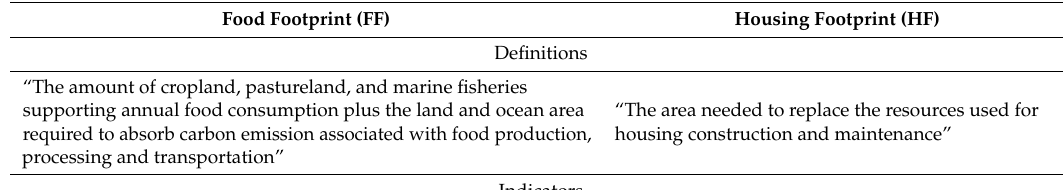
Table 2. Definitions and indicators used in the Redefining Progress programme for calculating Footprints (table adapted from Fern á ndez et al. [14]).